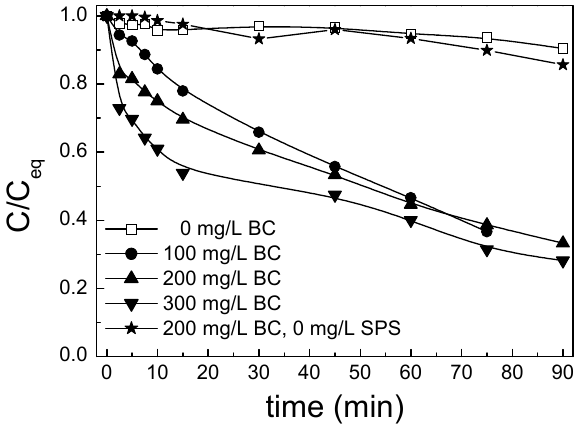
Figure 9. Effect of biochar concentration on 500 μ g/L SMX degradation with 1000 mg/L sodium persulfate (SPS) in ultrapure water (UPW) and inherent pH.